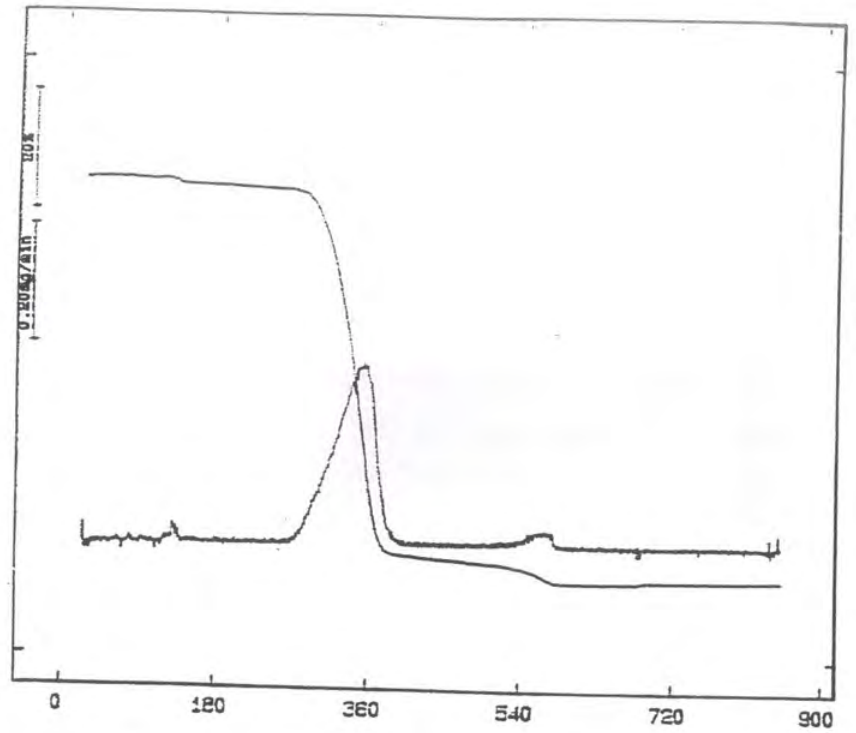
Figure 5. Thermal analysis (TG) for Polystyrene till 800 o